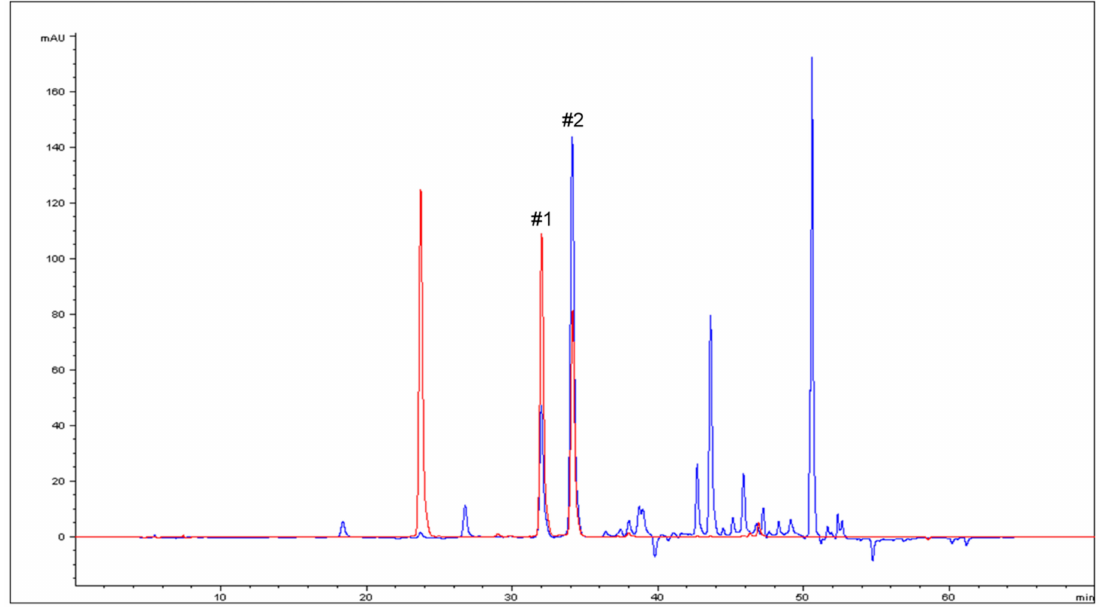
Figure 1. HPLC analysis. Overlapping of HPLC chromatograms obtained by anthocyanin standards (red curve) and pomace extract (blue curve), wavelength = 520 nm. #1 and #2 indicate the fractions collected and further analyzed by